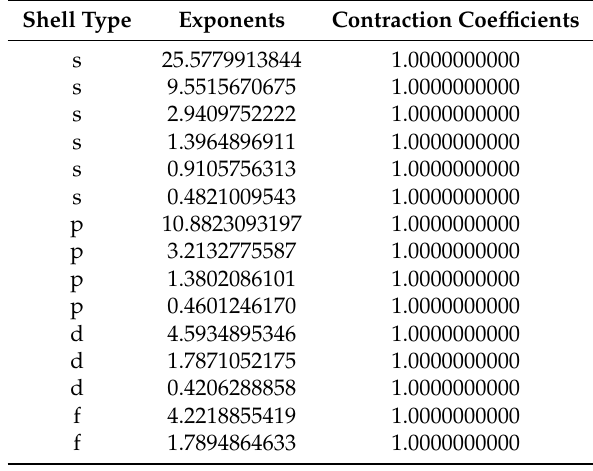
Table A22. Parameters of the cc-DZVP auxiliary basis set of Oxygen. Parameters taken from